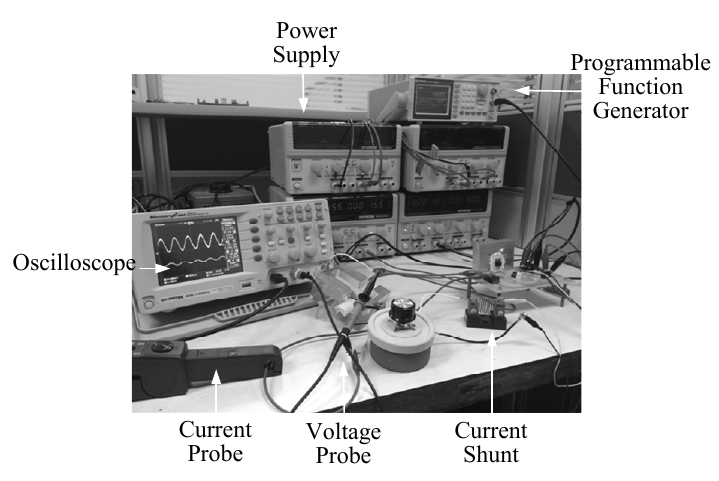
Figure 12. The picture of the battery charging test